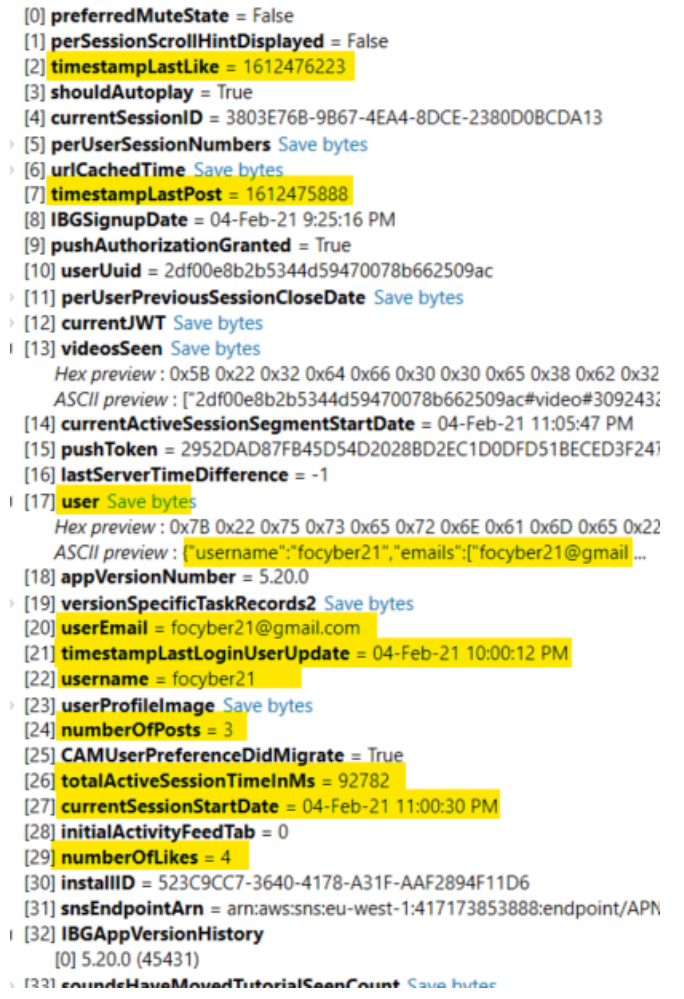
Figure 17. Dubsmash user profile and usage details recovered from